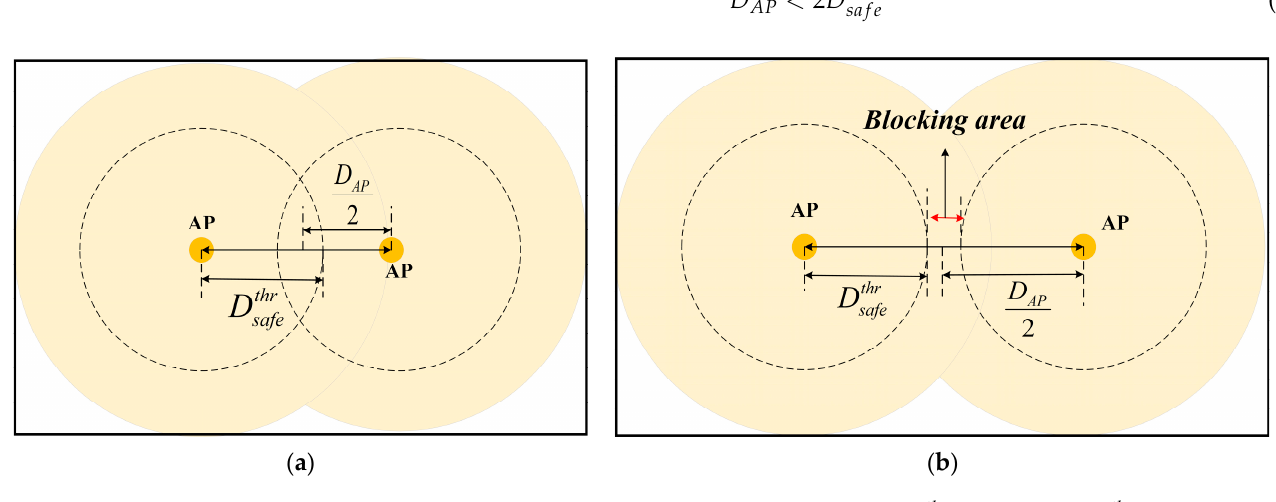
Figure 5. Influence of AP Spacing on VLC link: ( a ) 𝐷 (cid:3002)(cid:3017) < 2𝐷 (cid:3046)(cid:3028)(cid:3033)(cid:3032)(cid:3047)(cid:3035)(cid:3045) ; ( b ) 𝐷 (cid:3002)(cid:3017) ≥ 2𝐷 (cid:3046)(cid:3028)(cid:3033)(cid:3032)(cid:3047)(cid:3035)(cid:3045) .